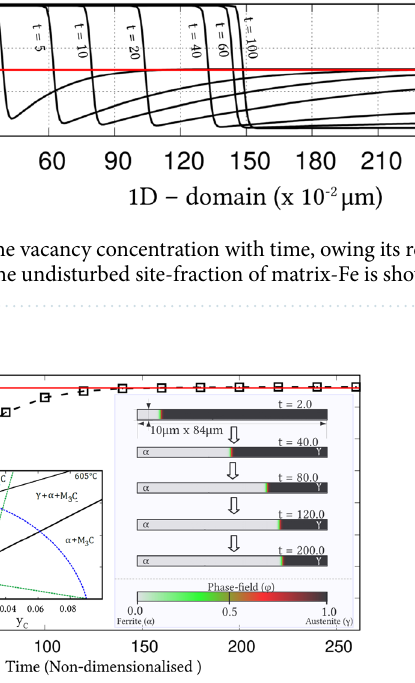
Figure 8. Progressive increase in the volume fraction of ferrite during the austenite decomposition of ternary Fe–C–Mn. As subplots, the isotherm of the ternary alloy at 878 K is included, besides the evolution of phase- field in quasi-one-dimensional domain that correspond to the phase